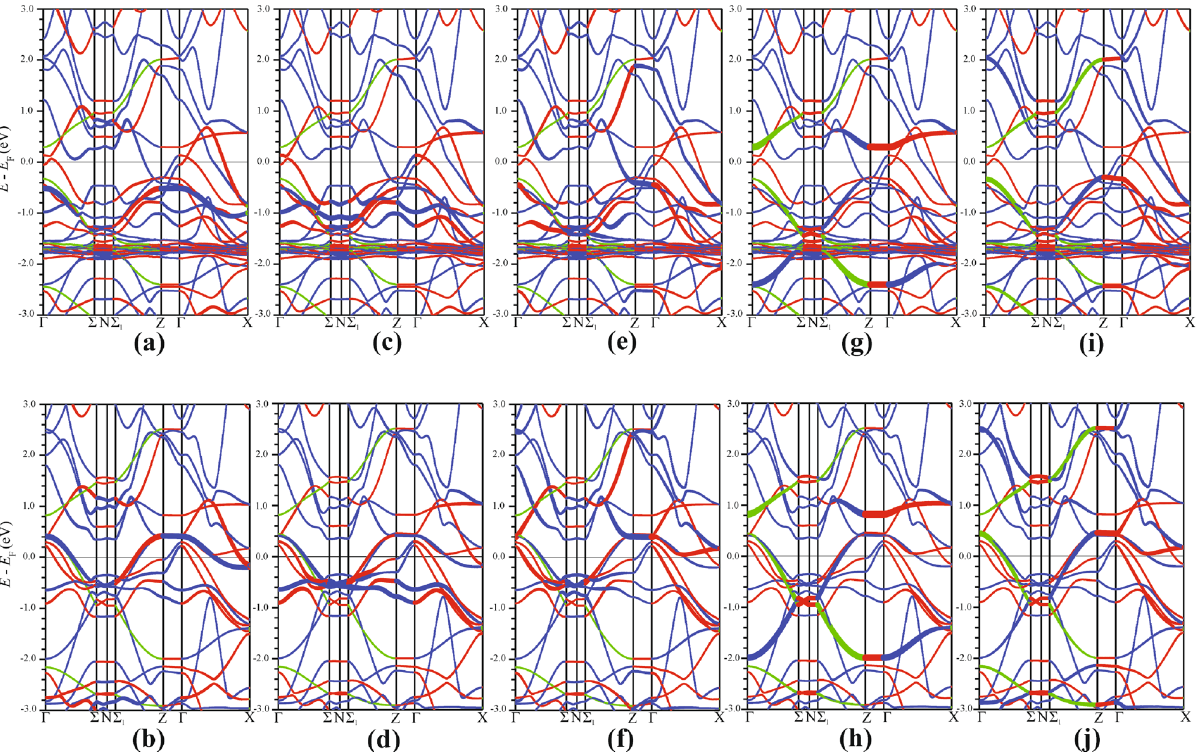
Figure 9. Spin-polarized, Fe 3 d orbital-resolved band structure shown by weighted bands in the background of the EuFeAs 2 energy bands. The d z 2 contribution to the spin-up ( a ) and spin-down ( b ) energy bands. The d x 2 − y 2 contribution to the spin-up ( c ) and spin-down ( d ) energy bands. The d xy contribution to the spin-up ( e ) and spin-down ( f ) energy bands. The d xz contribution to the spin-up ( g ) and spin-down ( h ) energy bands. The d yz contribution to the spin-up ( i ) and spin-down ( j ) energy bands. SigmaPlot v14, www. systa tsoft ware.